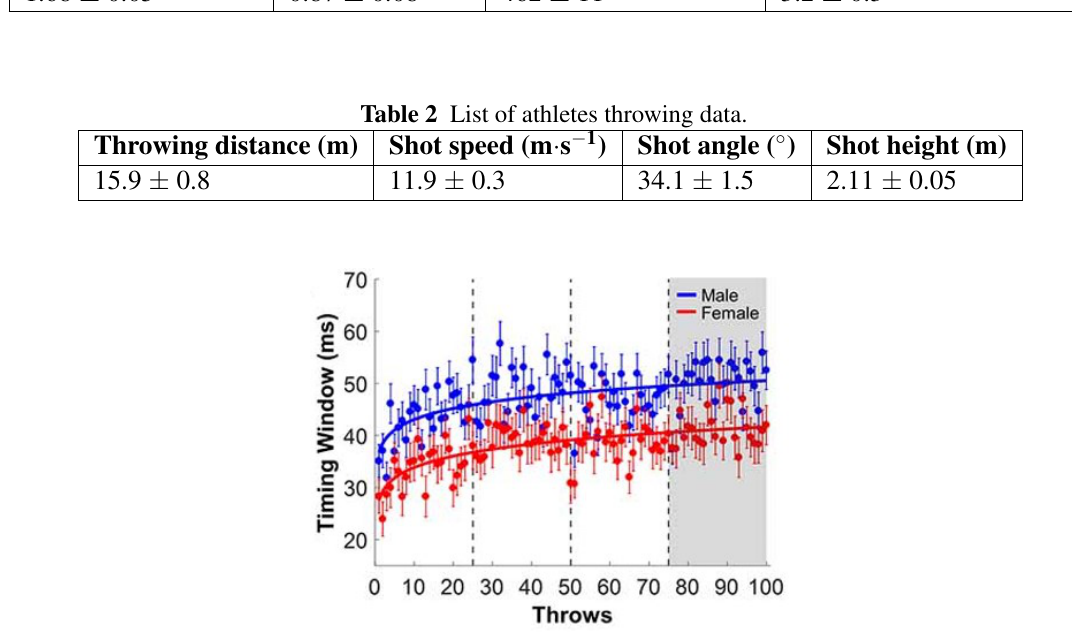
Fig. 5 Optimisation result display